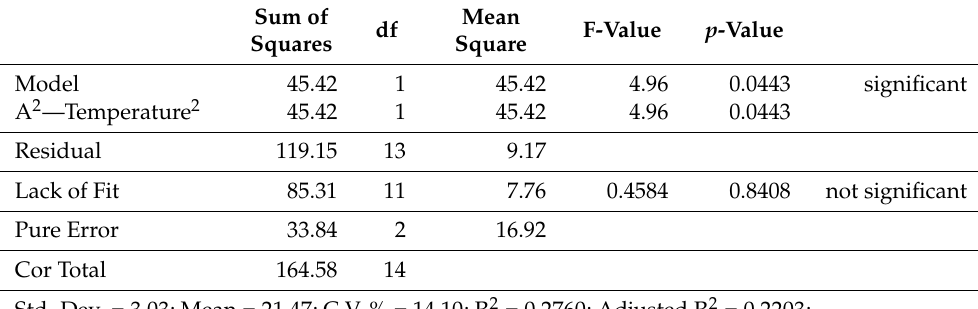
Table 8. Analysis of variance for antioxidant activity measured using FRAP